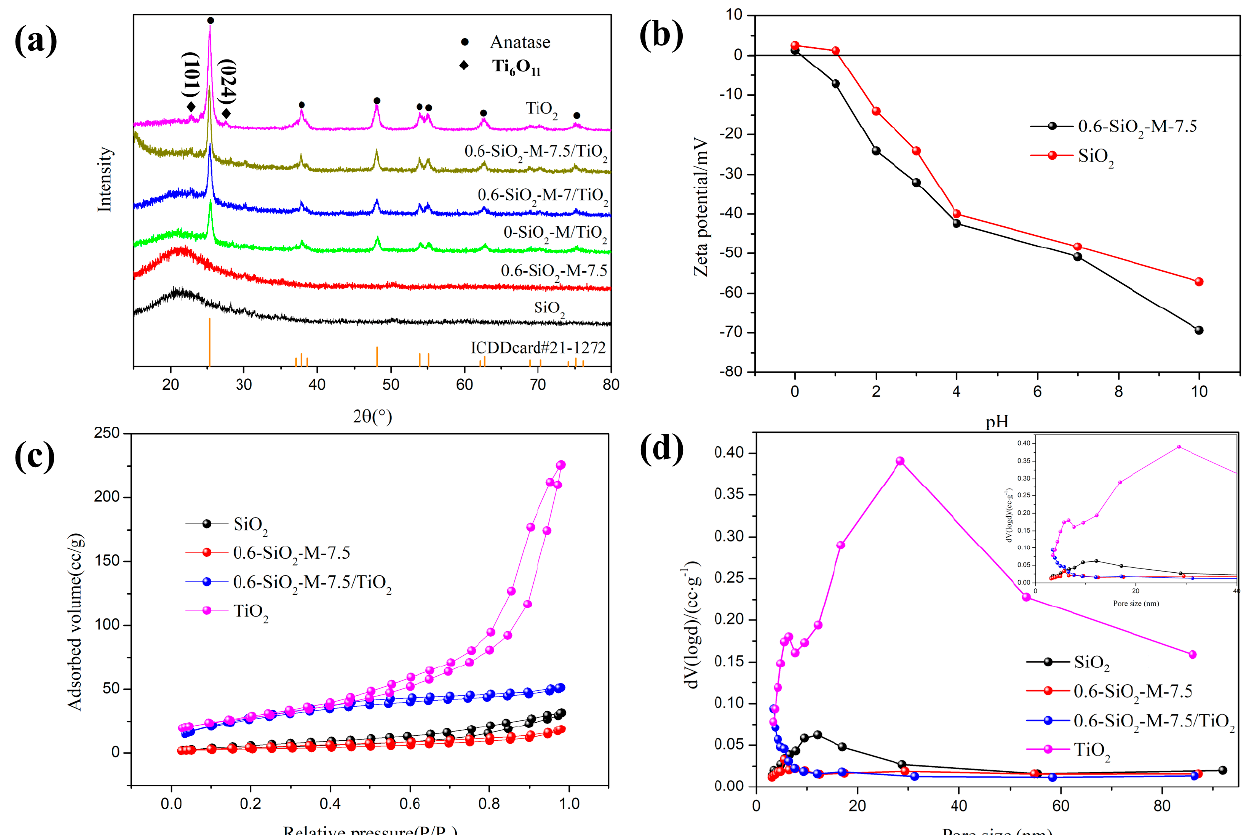
Figure 9. XRD patterns of SiO 2 , 0.6-SiO 2 -M-7.5, SiO 2 /TiO 2 , 0.6-SiO 2 -M-7/TiO 2 , 0.6-SiO 2 -M-7.5/TiO 2 , and TiO 2 ( a ); relationship between zeta potential and pH ( b ); N 2 adsorption–desorption curves; ( c ) and ( d ) pore-size distribution curves of SiO 2 , 0.6-SiO 2 -M-7.5, 0.6-SiO 2 -M-7.5/TiO 2 , and TiO 2 .